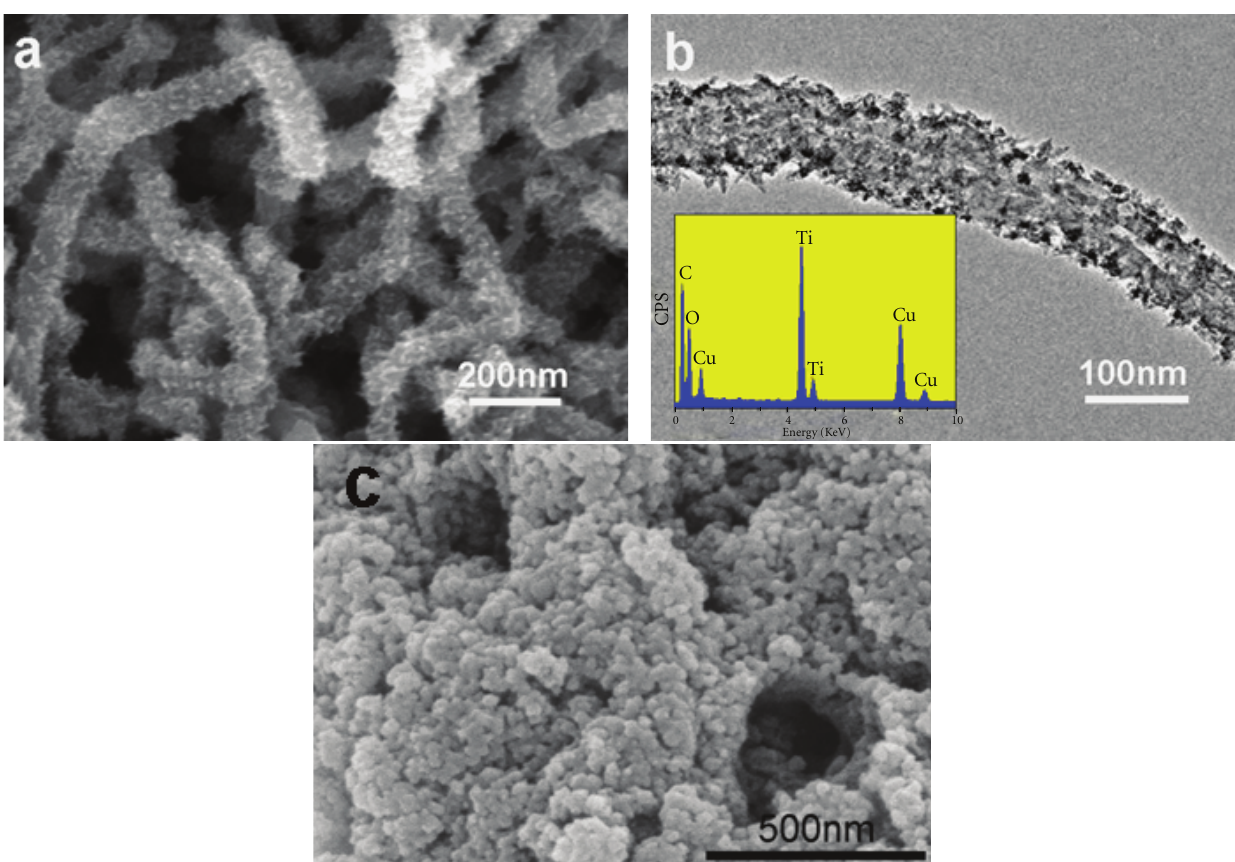
Figure 2: (a) Typical SEM image, (b) TEM image and EDS pattern (inset) of as-prepared CNT/TiO 2 heterostructures. (c) SEM image of the as-prepared TiO 2